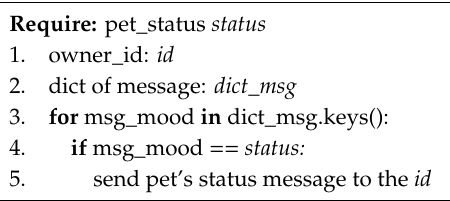
Algorithm 5 Message